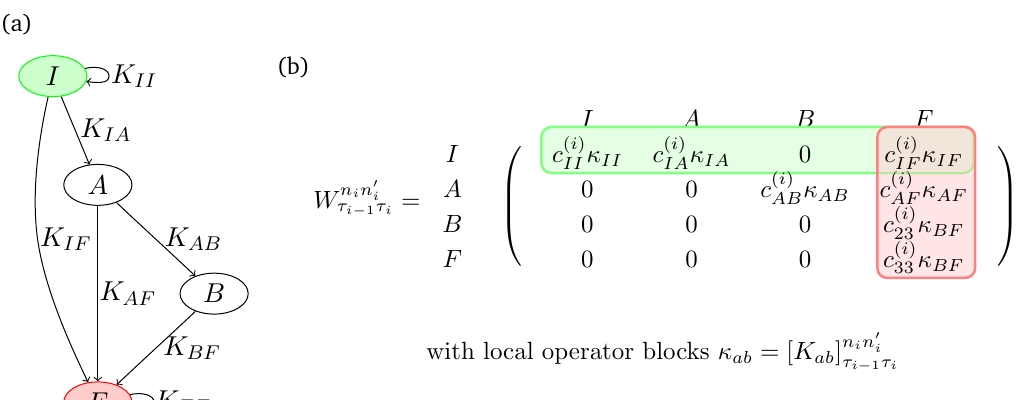
∈ (cid:75) . The ab . (b) Bulk MPO ab ( i ) are ab